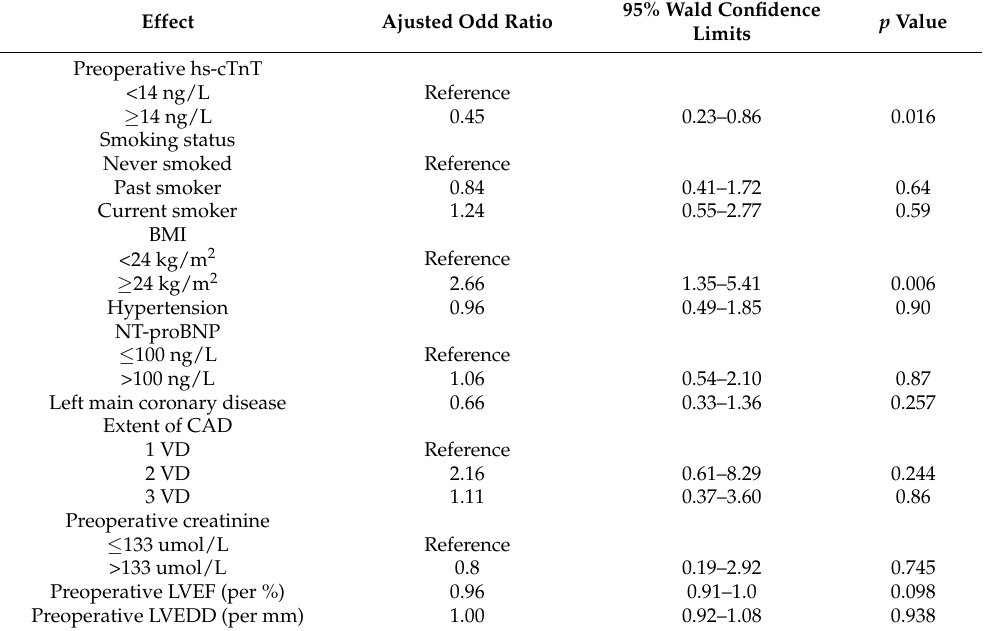
Table 5. Multivariable logistic regression model for early postoperative hypoxemia after OPCAB.